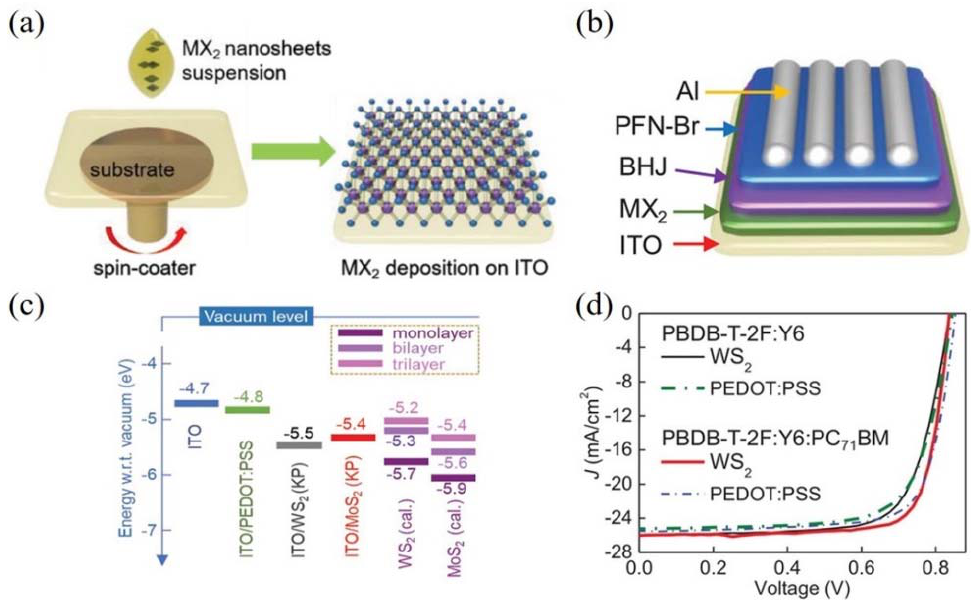
Figure 5. Schematic illustration of ( a ) the deposition of MoS 2 and WS 2 HTLs onto the substrate via spin-coating and ( b ) the device structure of OSCs; ( c ) The work function of ITO and HTLs deposited on ITO; ( d ) J-V curves of devices based on PBDB-T-2F:Y6 and PBDB-T-2F:Y6:PC 71 BM with PEDOT:PSS and WS 2 as HTL, respectively. Reprinted with permission form [83]. Copyright 2019 Deerfield Beach.